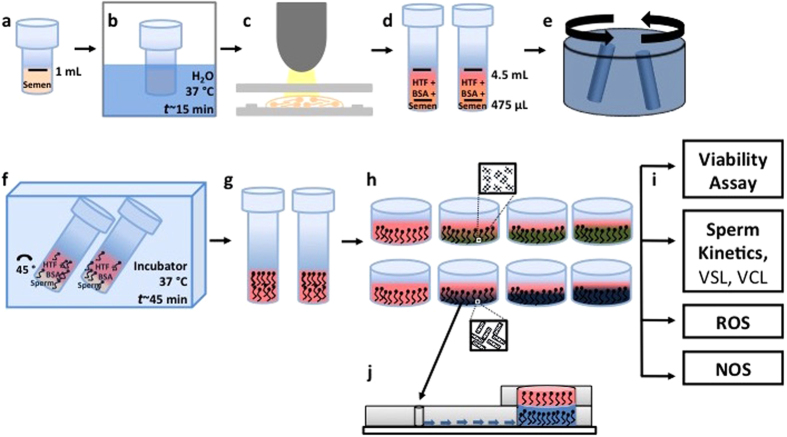
SWCNT-COOH/RGO concentration and time dependent sperm toxicity study.(a) 1 mL semen vials were obtained from a cryobank. (b) Semen sample was thawed in a water bath at 37 °C for 15 min. (c) Sperm concentration and motility were quantified using a Makler hemocytometer. (d) Semen samples were mixed with HTF and 1% BSA and (e) centrifuged. (f) Sperm samples were placed in an incubator and motile sperm were allowed to swim up to the top media layer. (g) Supernatant containing motile sperm was collected and distributed in 8 wells. (h) Sorted semen were incubated with SWCNT-COOH and RGO at various concentrations; 1, 5, 25 μg/mL, and for 30 minutes or 3 hour time points. (i) Viability, sperm kinetic parameters, ROS, and NO were measured. (j) Sperm incubated with nanomaterials were processed using a microfluidic device to investigate the effects of nanomaterials on sperm sorting process.